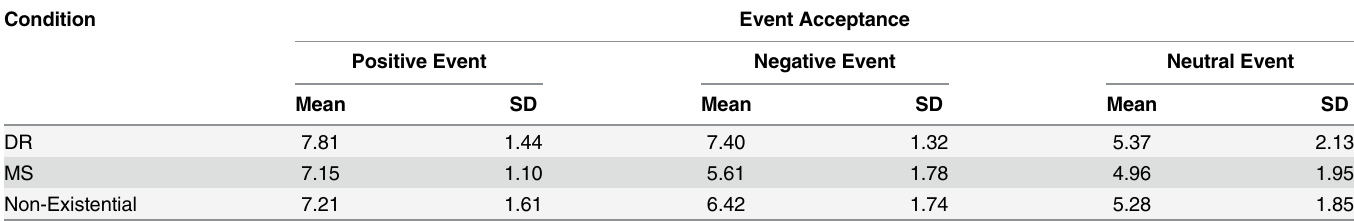
Table 1. Means and Standard Deviations for Event Acceptance as a Function of Condition in Experiment